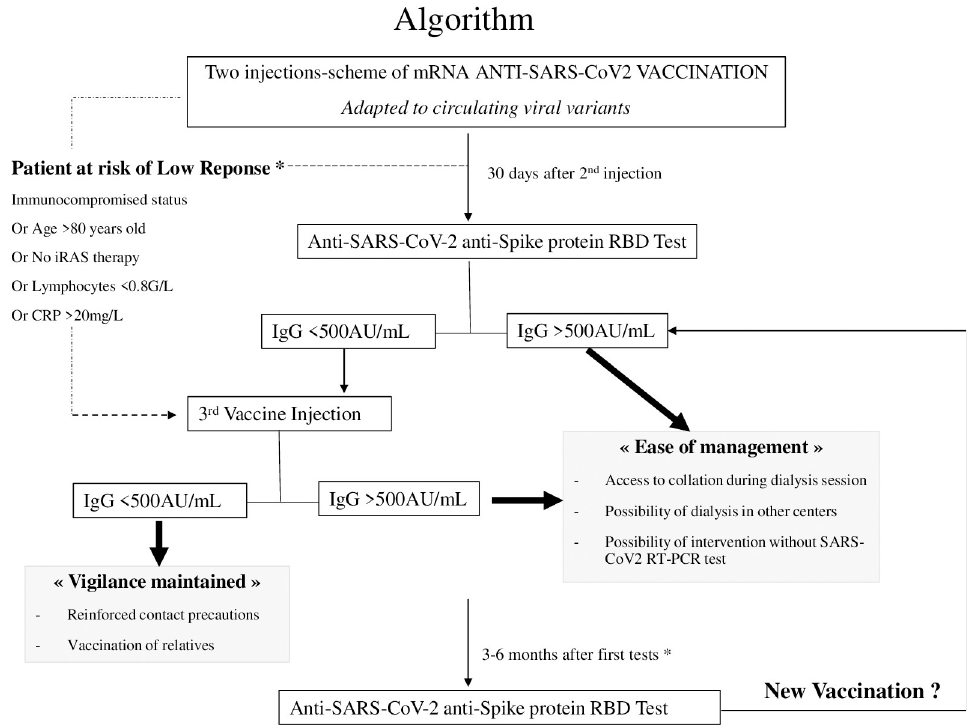
Fig 2. Proposed algorithm integrating anti-SARS-CoV-2 Spike-Protein-RBD antibody monitoring to manage dialysis centers.